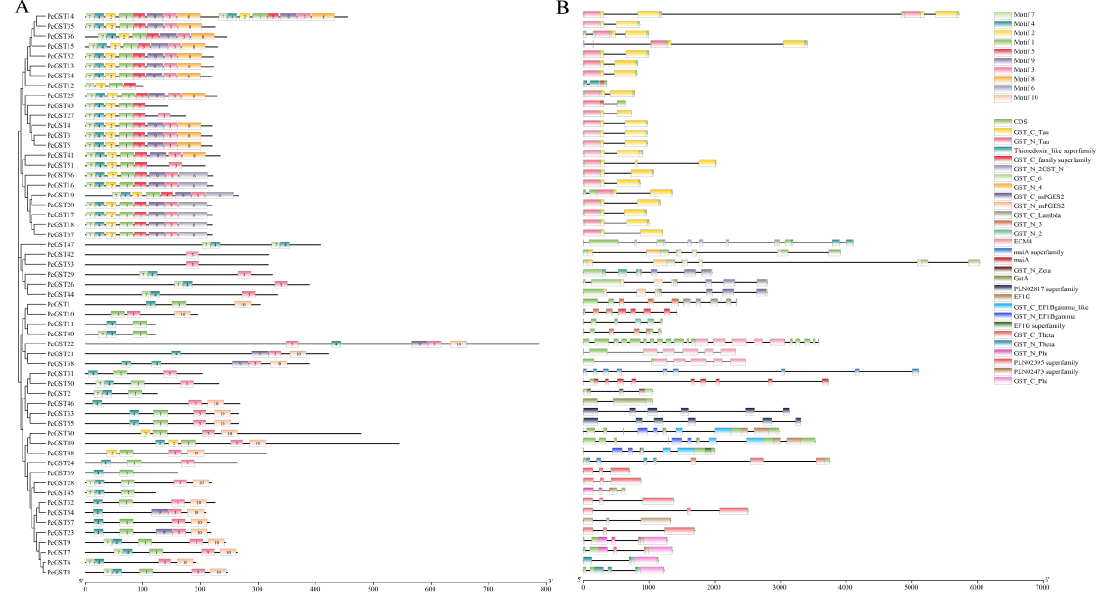
Figure 4. Structure and conserved domain analysis of PcGST genes. ( A ) Phylogenetic relationship and conserved motif analysis of PcGST genes. The boxes with different colors indicated different motifs. ( B ) Exon–intron structure and conserved domain analysis of PcGST genes. The conserved GST domains were exhibited with indicated colors, and the introns were shown as black